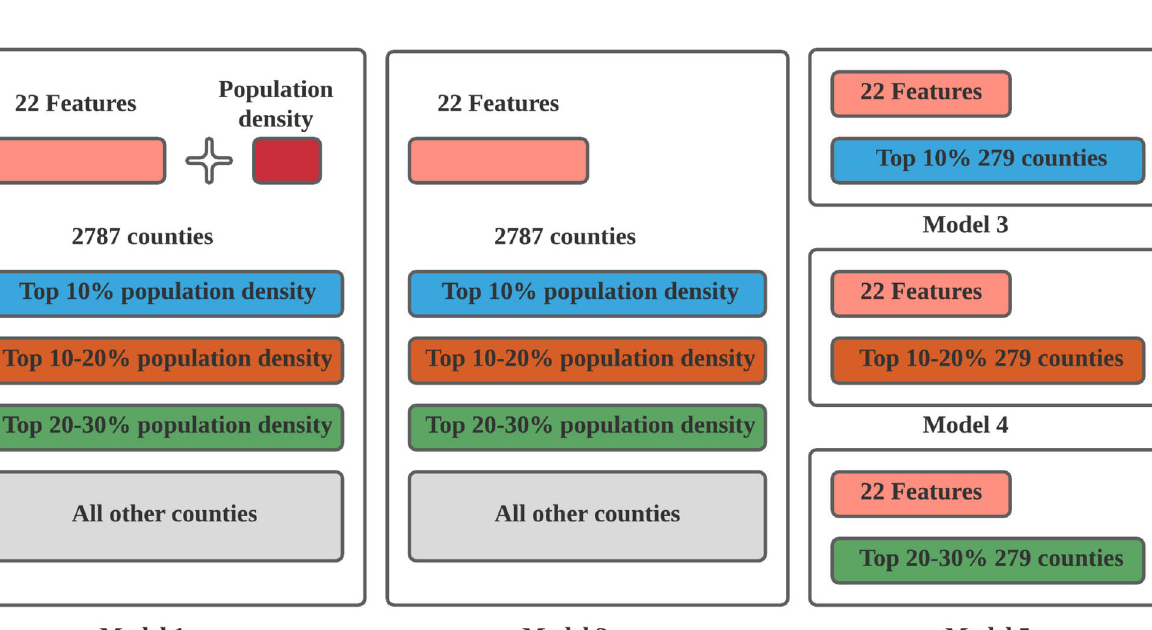
five sets of random forest models. Figure 2 illustrates clusters of counties with varying population densities in models. We explain each random forest model in the following sub-sections. Two base models.